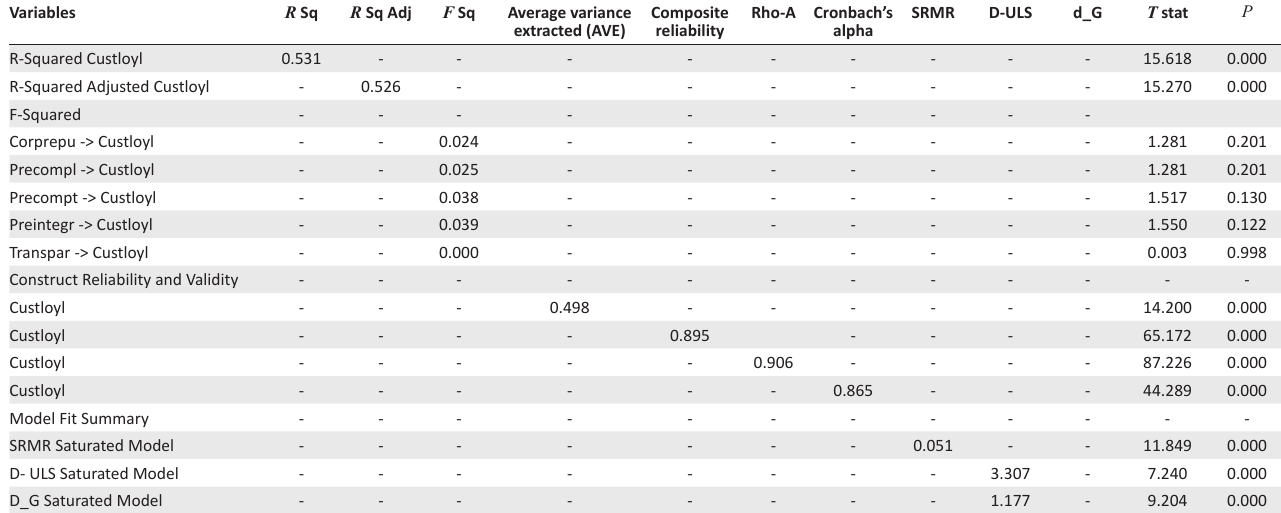
TABLE 1: Model fitness and quality indices.